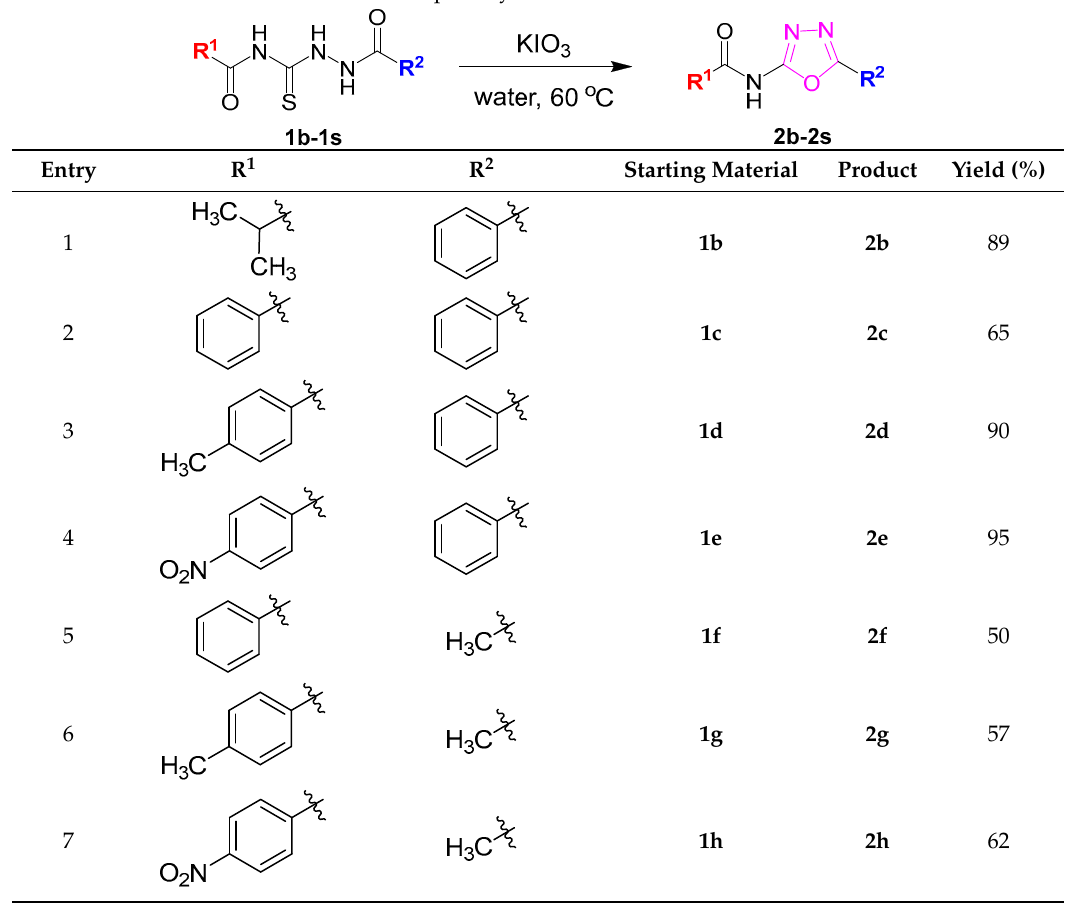
Table 2. Reaction scope of cyclization of the thiosemicarbazide.